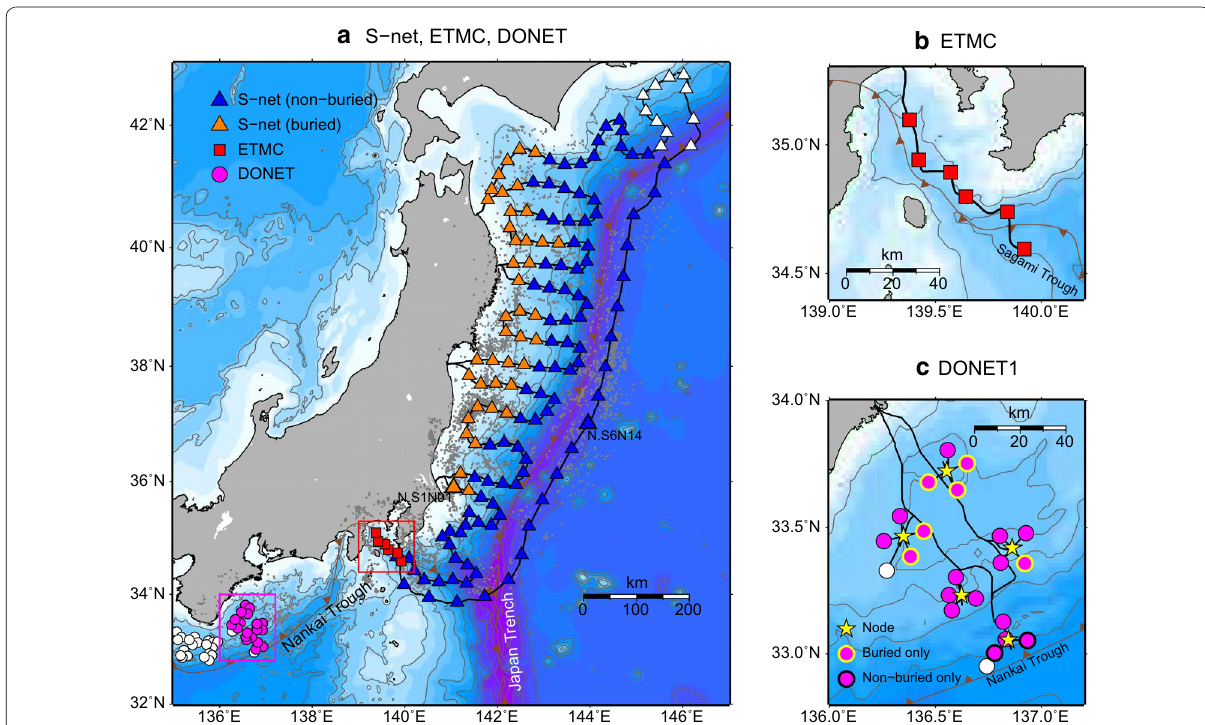
Fig. 2 Location of the studied OBS stations. Triangles, squares, and circles in a represent S-net, ETMC, and DONET stations, respectively. Orange and blue triangles represent the S-net stations installed and not installed within grooves in the seafloor, respectively. Gray dots are the epicenters of used earthquakes. Bathymetric contour lines are drawn at 1000 m intervals. b and c are enlarged maps of the areas enclosed by red and purple rectangles in a , respectively. In c , stations with yellow and black outlines were only used for buried and non-buried time periods, respectively. Stations with white were not used in this